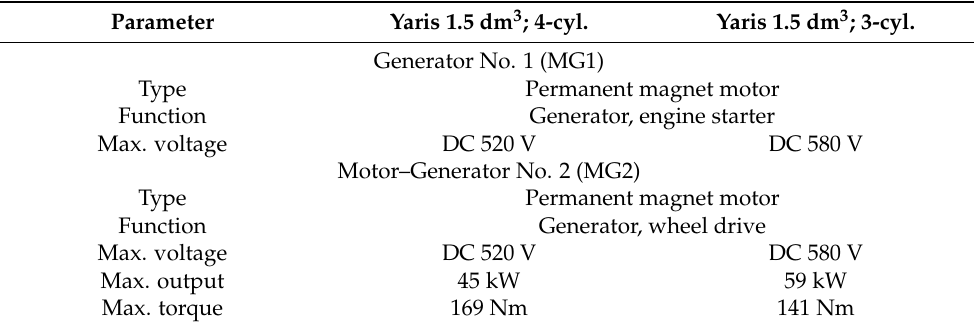
Table 2. Characteristics of the MG1 generators and MG2 motors in both powertrains [18–20].